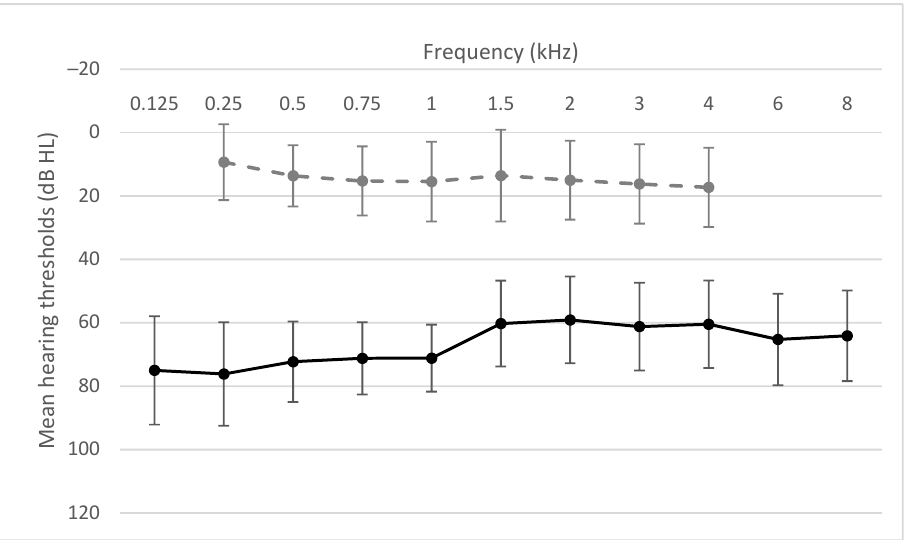
Figure 4. Air conduction thresholds (black solid line) and bone conduction thresholds (gray dashed line).